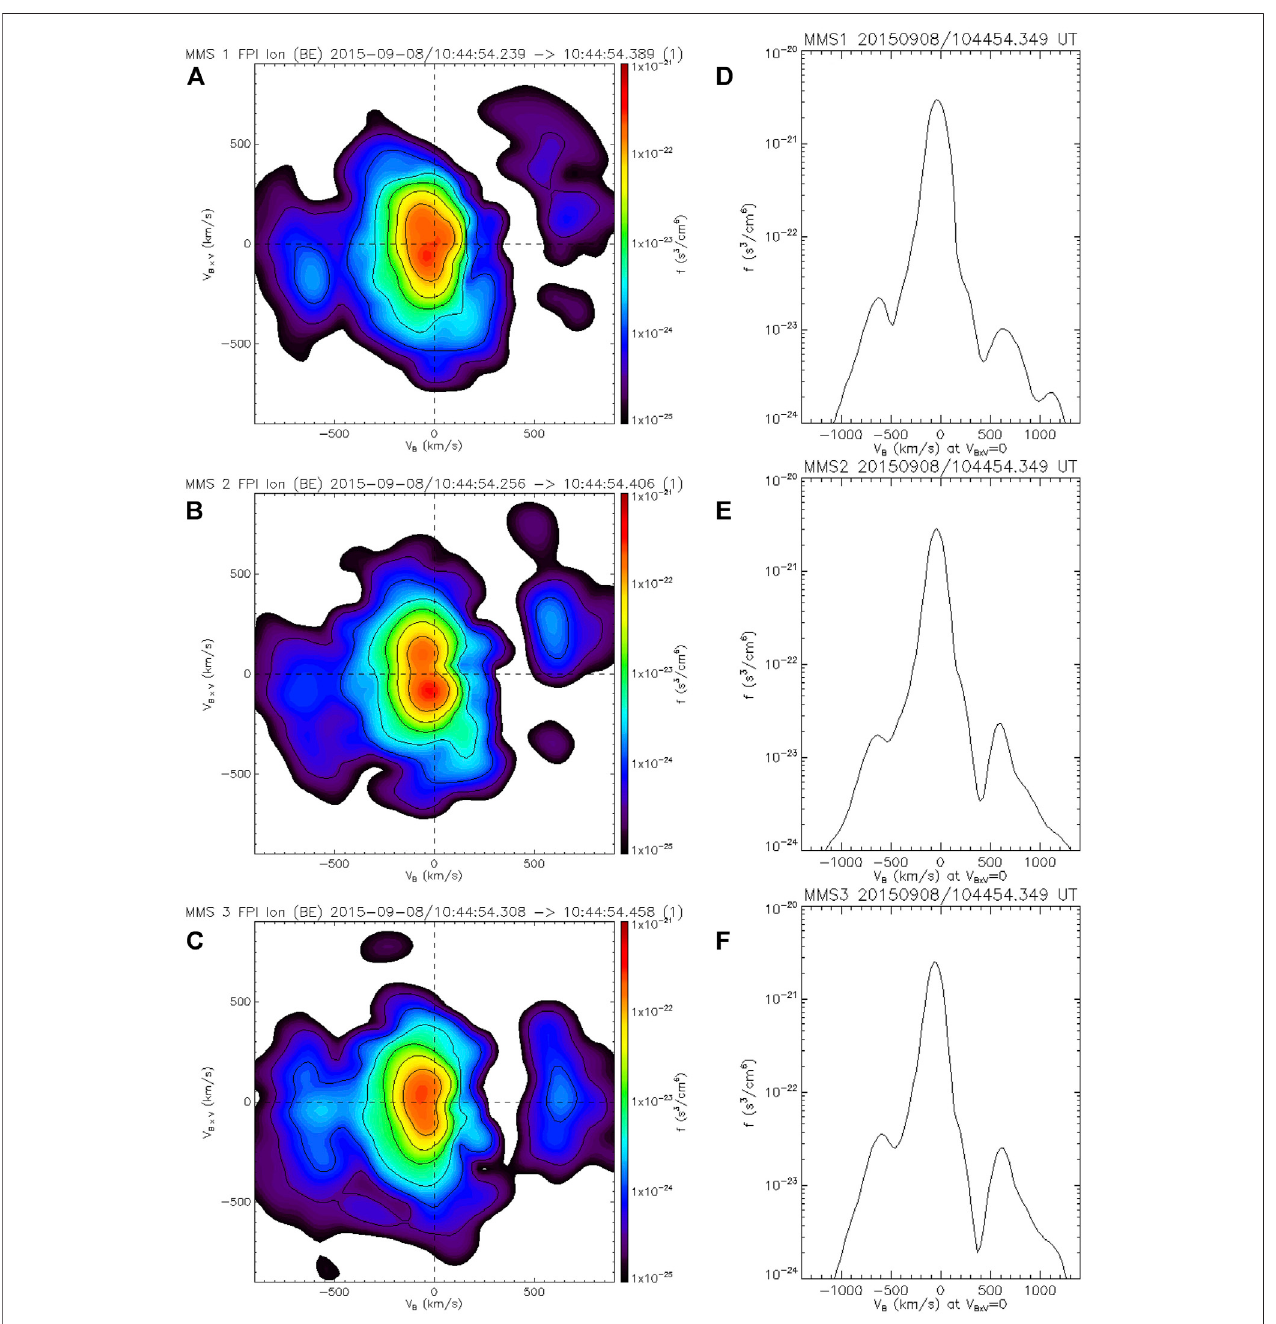
FIGURE13| Ionvelocitydistributionfunctionsat1044:54.349UT: (A) 2-DionphasespacedensityatMMS-1; (B) 2-DionphasespacedensityatMMS-2; (C) 2-D ion phase space density at MMS-3; (D) 1-D cut at MMS-1; (E) 1-D cut at MMS-2; (F) 1-D cut at MMS-3.